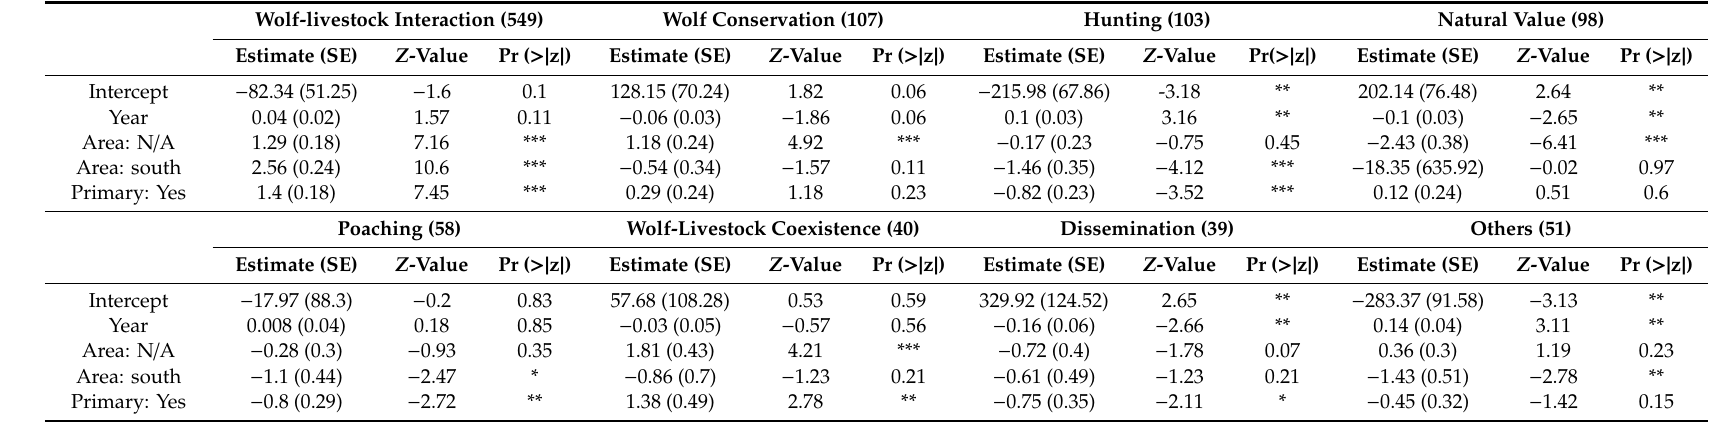
Table 1. Results of logistic regressions used to test for associations between the topics identified in the documents and AREA (north of the River Douro, south of the River Douro, and non-assignable documents), PROTA (primary and secondary articles), and YEAR (2006–2017). The number of documents on each topic is shown